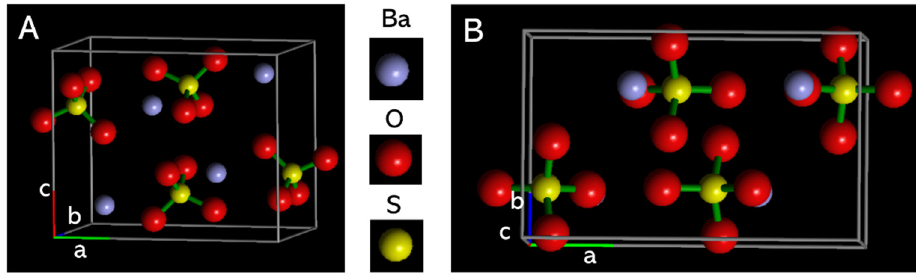
Figure 2. Barite unit cell, ball, and stick model. ( A ): Side view; ( B ): top (001) view. The figure is produced by using XtalDraw 1.0 program [37].